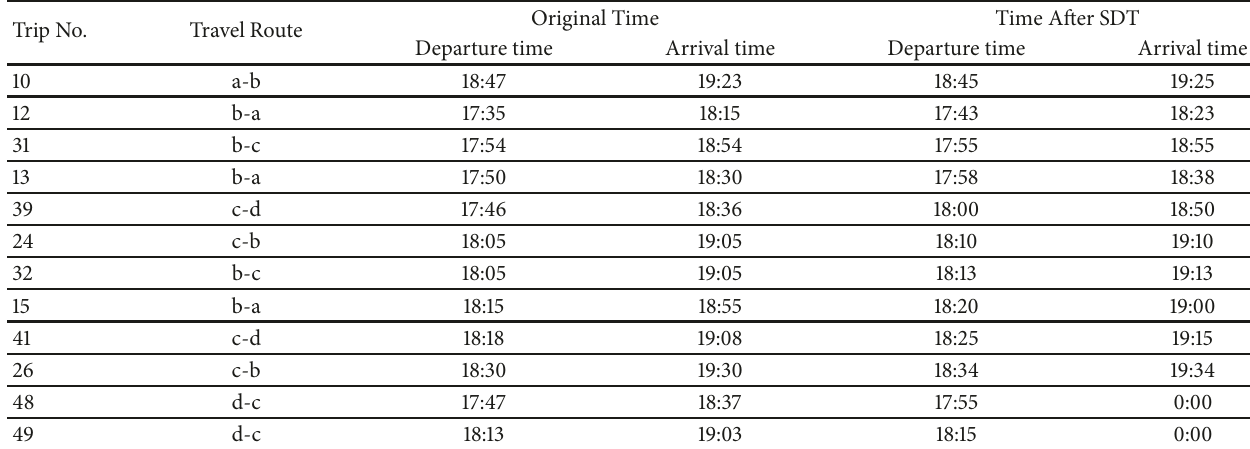
Table 5: SDT for the twelve trips.